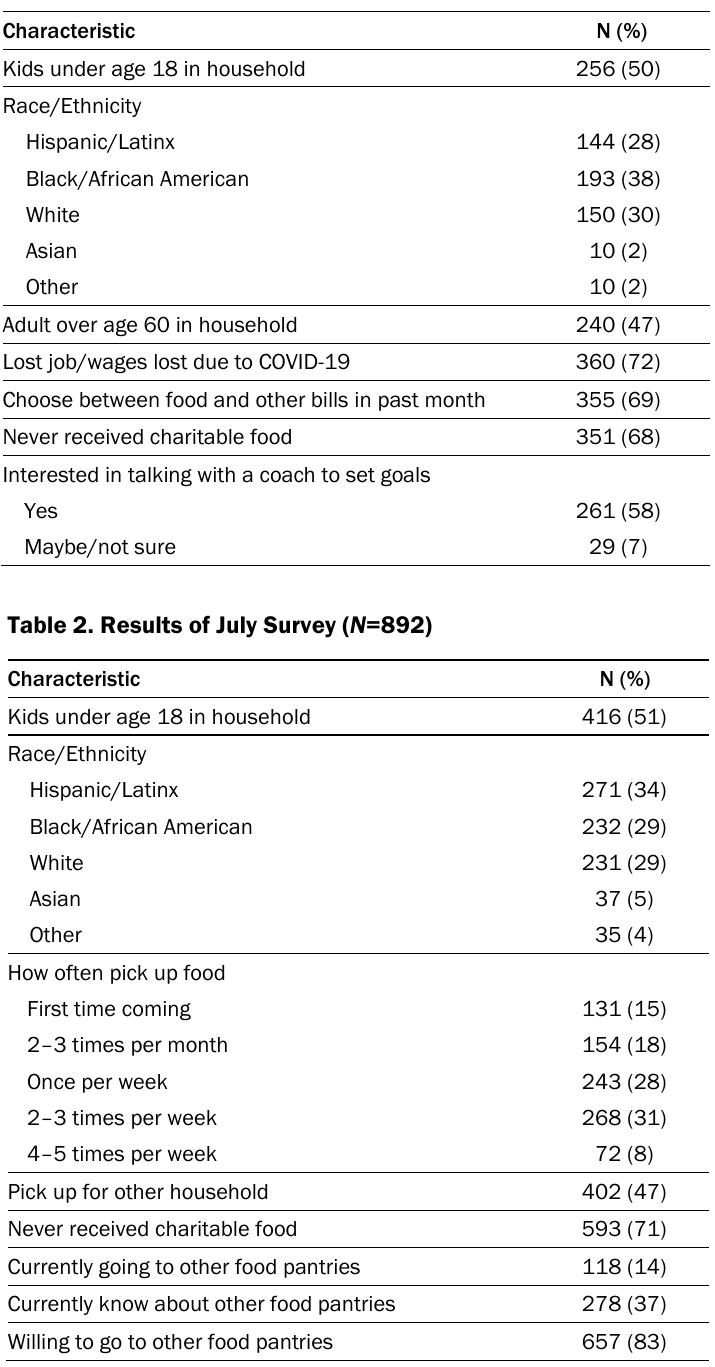
Table 1. Results of Spring Survey ( N =513)